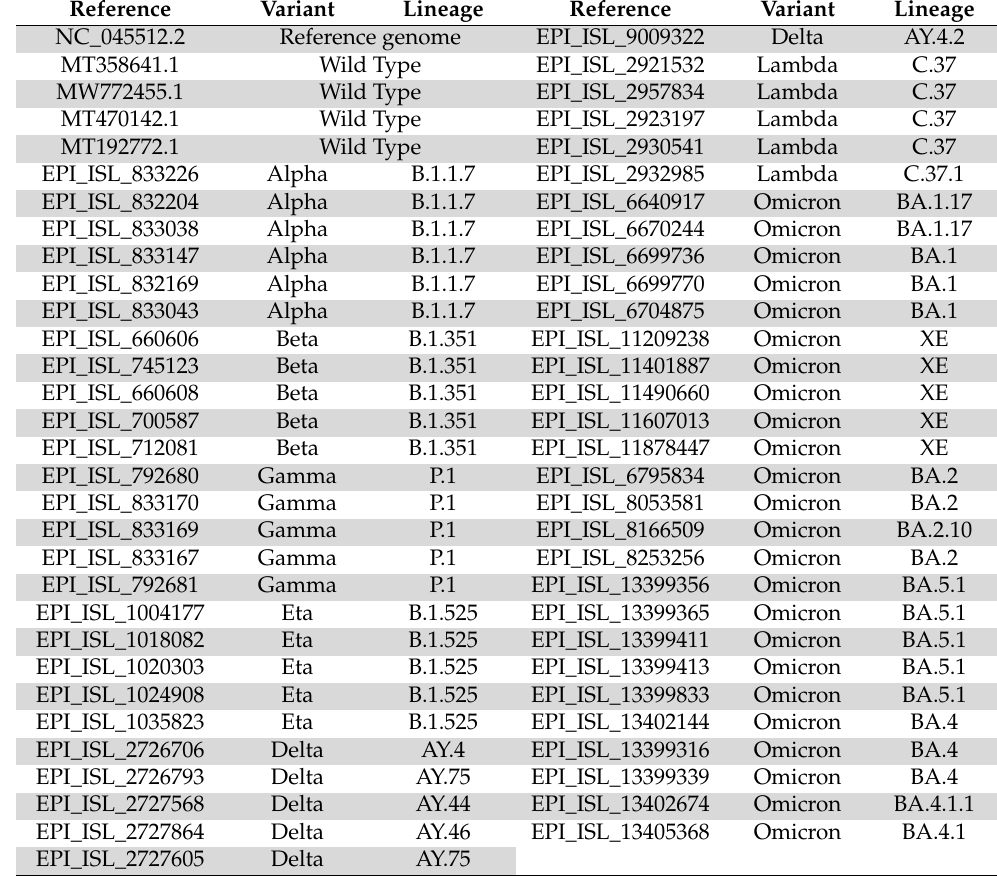
Table A2. The sequences included in the reference